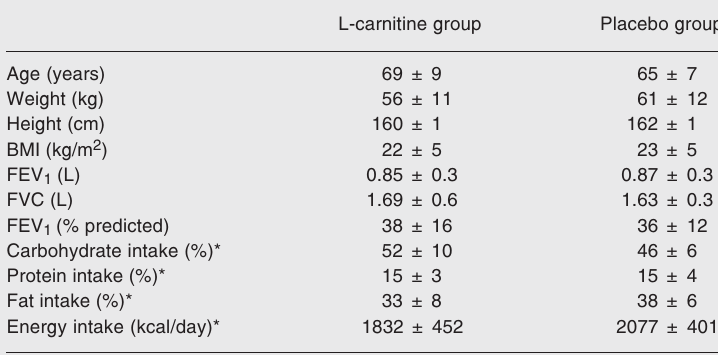
Table 1. Characteristics of the patients in the L-carnitine and placebo